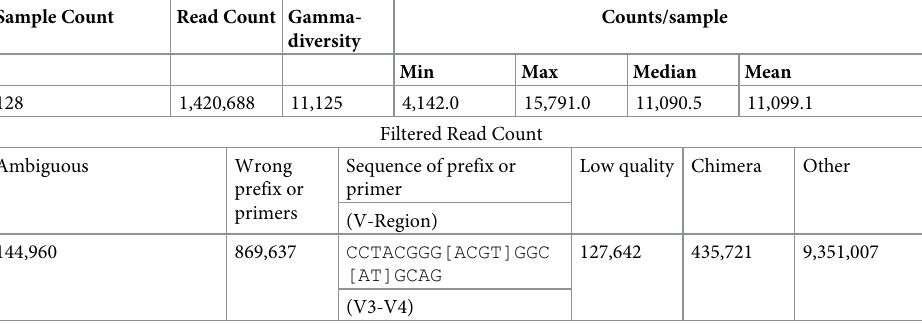
Table 1. Summary of results of preprocessing and